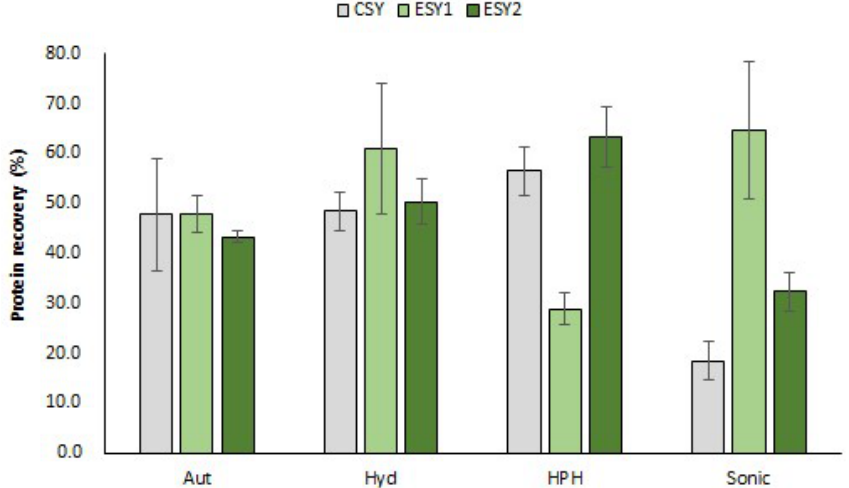
Figure 2. Protein recovery (%) of each extraction process (Aut—autolysis, Hyd—enzymatic hydrolyis, HPH—high pressure homogenization, Sonic—sonication) applied to the different yeast strains (CSY, ESY1 and ESY2).